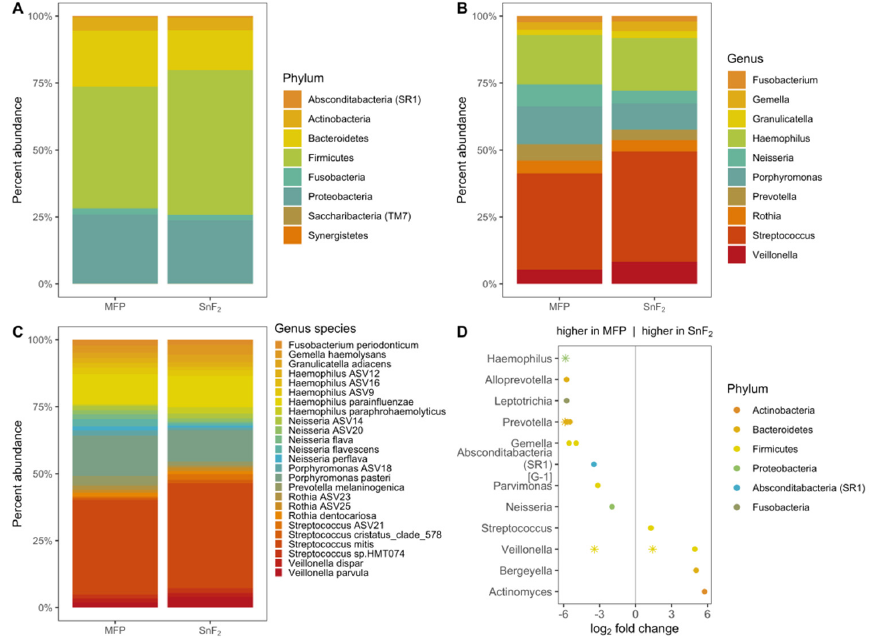
Figure 5. Oral bacterial community composition with the use of sodium monofluorophosphaste (MFP) and SnF 2 -containing toothpastes. Stacked bar plots showing relative abundance of taxa at phylum ( A ), genus (top 10) ( B ), and species (top 25) ( C ) levels in biofilms formed with MFP and SnF 2 -containing toothpaste use. ( D ) Plot showing differential abundance of taxa at the genus level. The genera represented higher in MFP and SnF 2 biofilms, which are shown on the left and right side of the central line, respectively. Only genera with p < 0.1 are plotted and significantly different genera ( p < 0.05) are denoted as asterisks (Wald significance Test). Table 2. List of differentially abundant taxa observed in SnF 2 vs. sodium monofluorophosphate (MFP) populations.